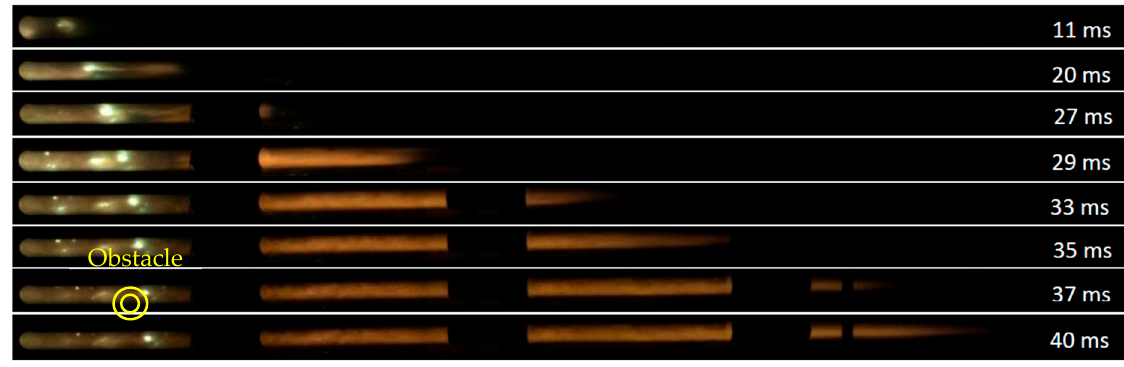
Figure 11. 10% methane–air flame propagation in the straight tube.